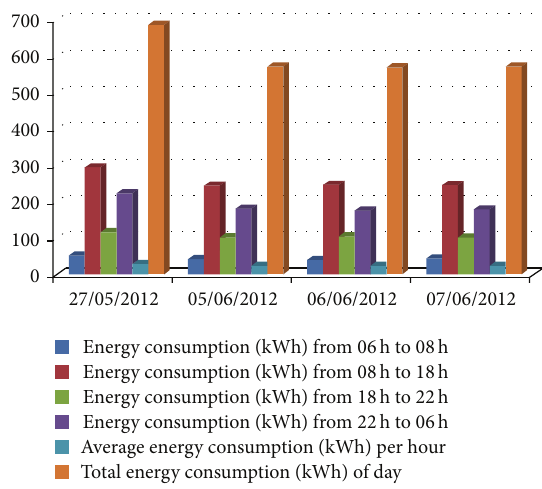
Figure 11: Comparison between energy consumption of the site, case of a day not applying the proposals of energy savings (27/05/2012), case of a day for which the air conditioner was under failure,andcaseofdaysapplyingtheproposalsofenergysavings(05, 06, and 07 June